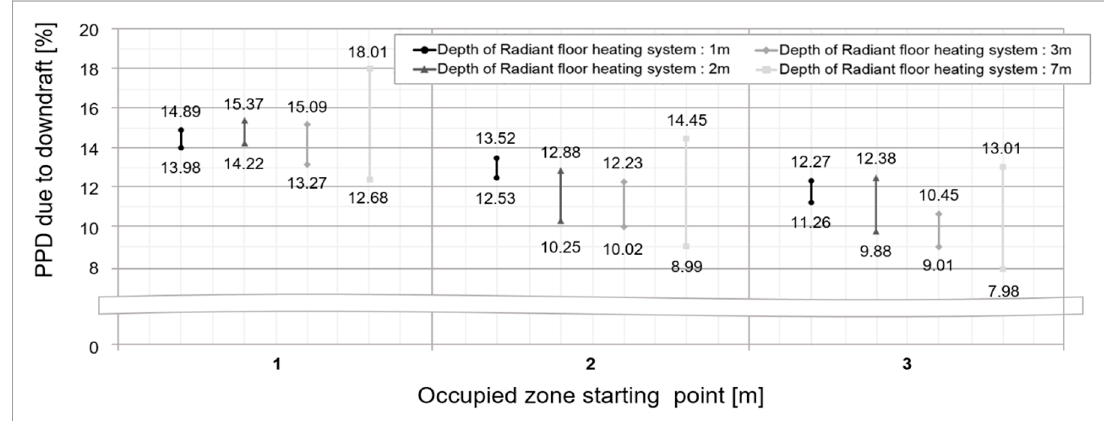
Figure 18. The relationship between RFHS and discomfort (the point when the occupation area is starting).